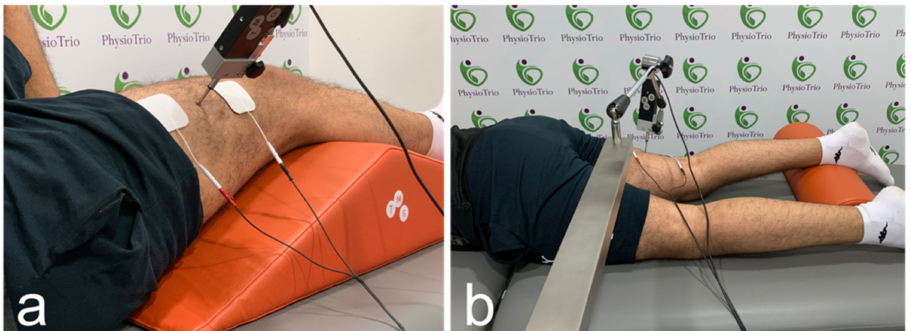
Figure 1. Acquisition locations for shear wave elastography and probe placements for tensiomyogra- phy during the assessments of the vastus lateralis ( a ) and biceps femoris ( b